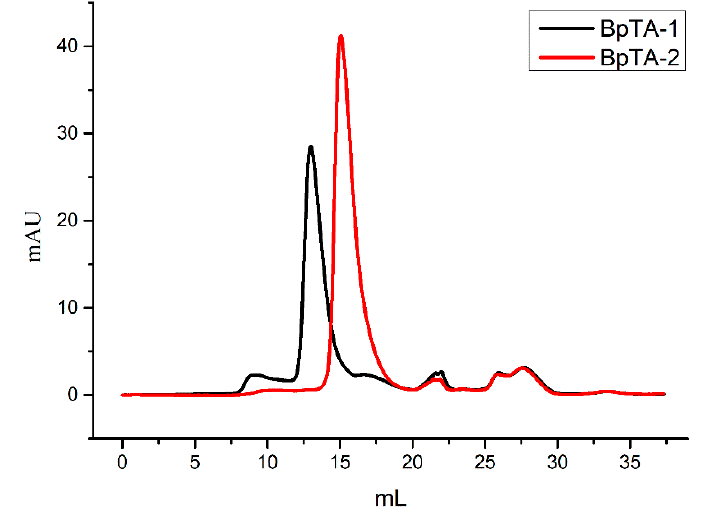
Figure 4. The size-exclusion chromatography elution curves of BpTA-1 and BpTA-2.